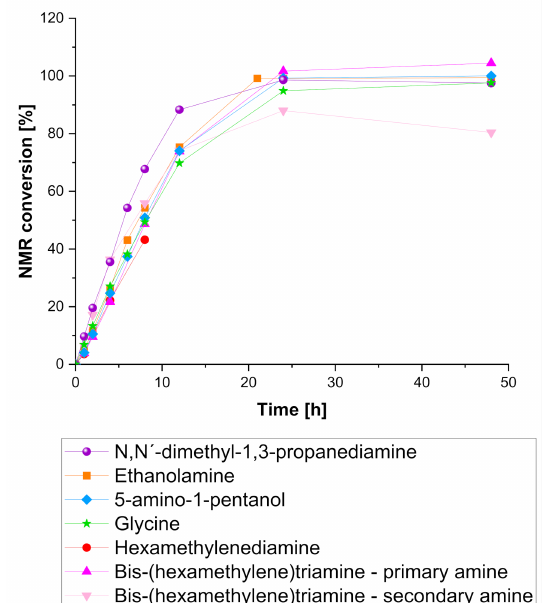
Figure 2. Ureido NMR conversion as a function of reaction time for different substrates. The reactions were conducted at 80 ◦ C with 5% v/v of the amine molecule in H 2 O/D 2 O and with a 6-fold urea excess: ethanolamine/urea = 1:6; 5-amino-1-pentanol/urea = 1:6; hexamethylenediamine/urea = 1:6; N;N (cid:48) -dimethyl-1;3-propanediamine/urea = 1:12; bis-(hexamethylene)triamine/urea= 1:18; glycine/urea = 1:6; pyrrole/urea =